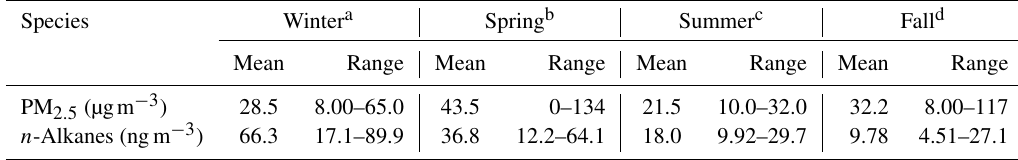
Table 1. PM 2 . 5 and particulate-bound n -alkane concentrations in different seasons in Beijing. Species